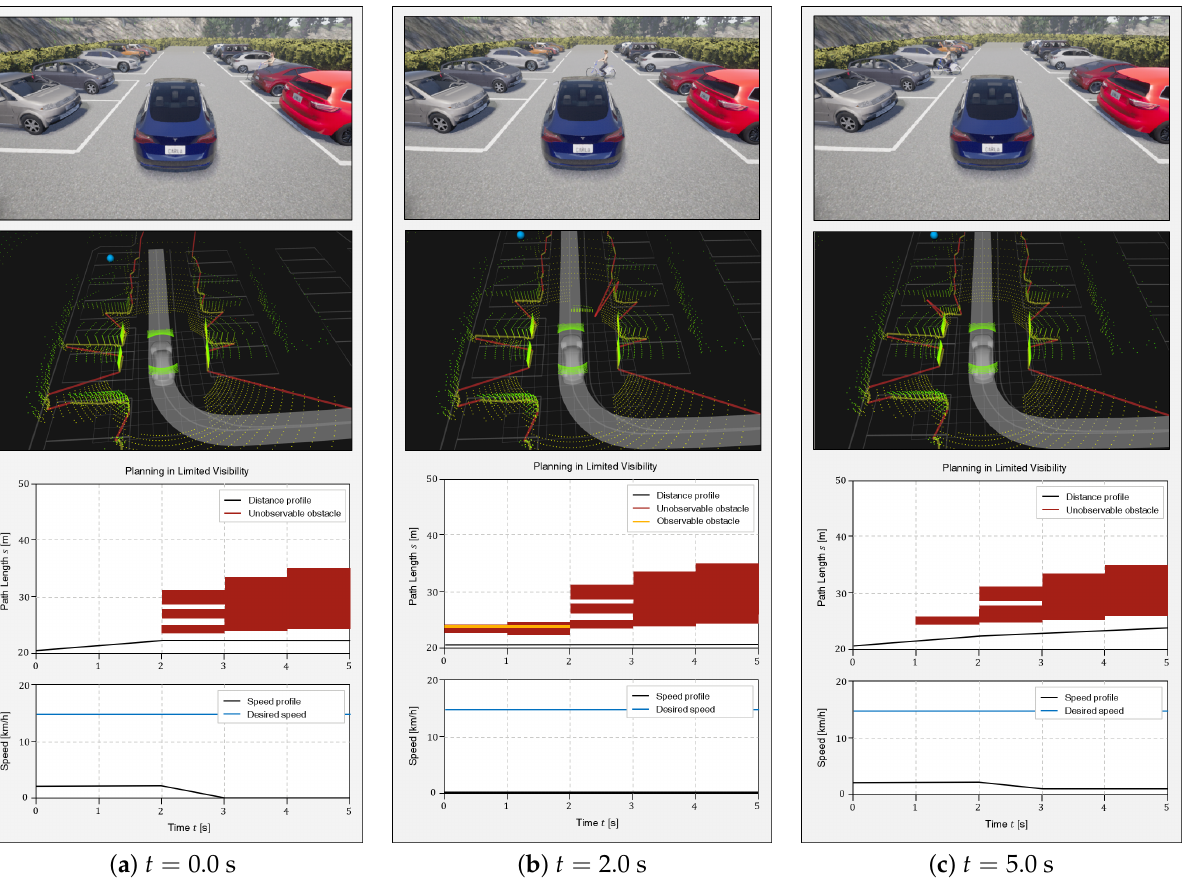
Figure 11. Roaming in a parking lot with obstacles. The upper figure of each time step shows the situation in CARLA. The second figure describes the algorithm in ROS platform. The last figure shows the speed profile at each time